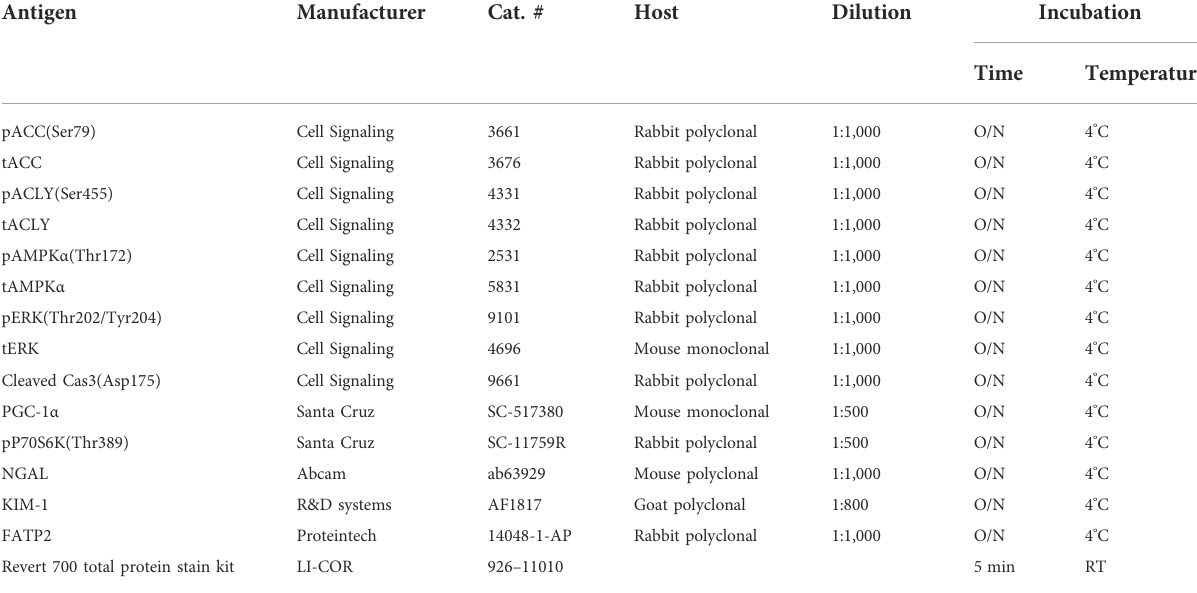
TABLE 1 Antibodies used for western